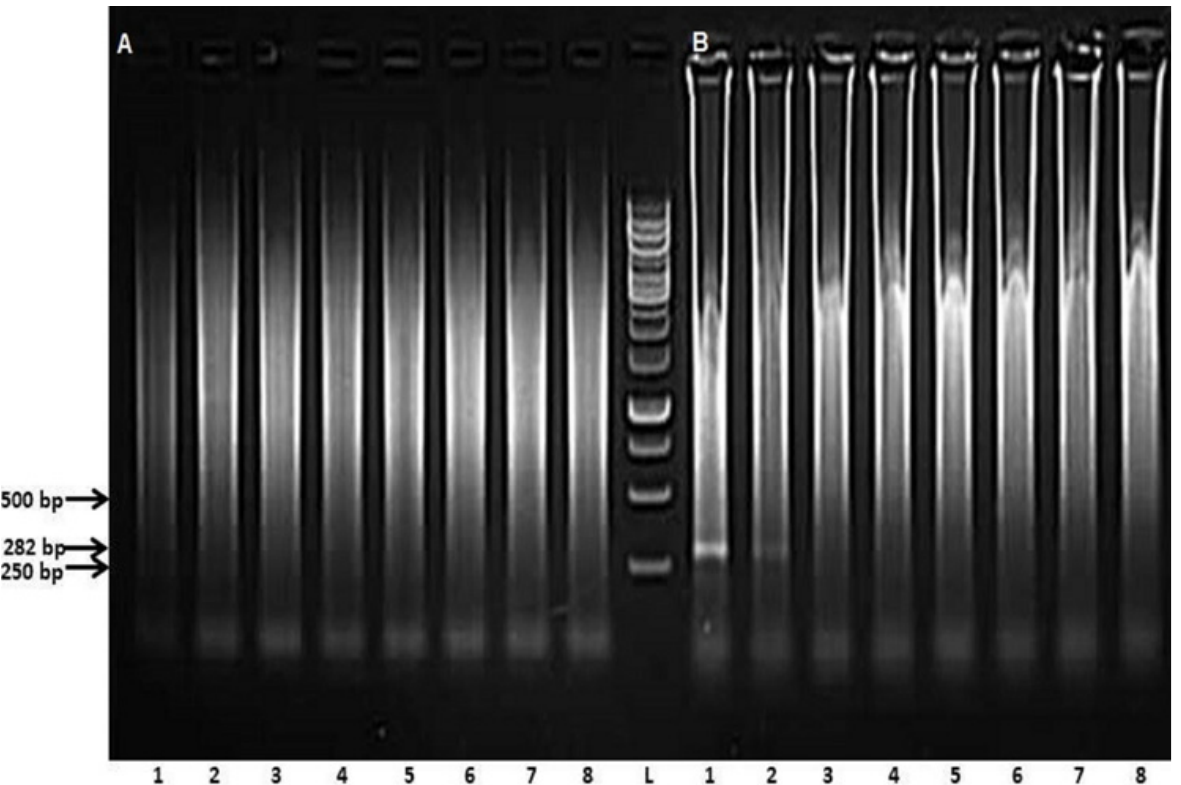
Figure 3. Calibration of the nested PCR reaction using B. melitensis 16M genomic DNA. Left-hand side, DNA amplification of the intact omp2a gene of a genomic DNA source diluted by a ten-fold factor. An expected band at 1200 bp is not depicted in any of the reactions, Lanes 1–8. Right-hand side, a “nested PCR” DNA amplification of a 282 bp size partial sequence within the intact omp2a gene is seen in Lanes 1 and 2, to the right side of a GeneRuler 1 kb DNA ladder, corresponding to 4.5 and 0.45 ng of the original genomic DNA concentrations in the first amplification reactions (Left hand side, Lanes 1 and 2), respectively.